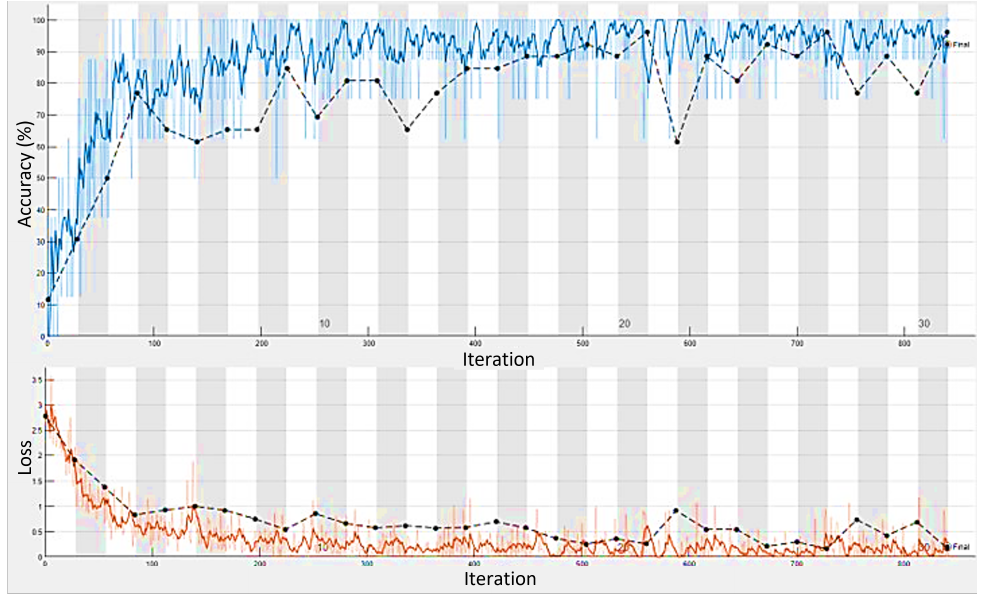
Figure 18. Proposed network with a mini-batch size of 8 and an initial learning rate of 0.0001. The algorithm was tested under different conditions. Testing accuracy of 86.84% is obtained when the subject and background of the environment remain the same as the one trained on. However, when tested on a random person from the dataset with a different environment, the testing accuracy obtained was 53.33%, as depicted in Figure 19.